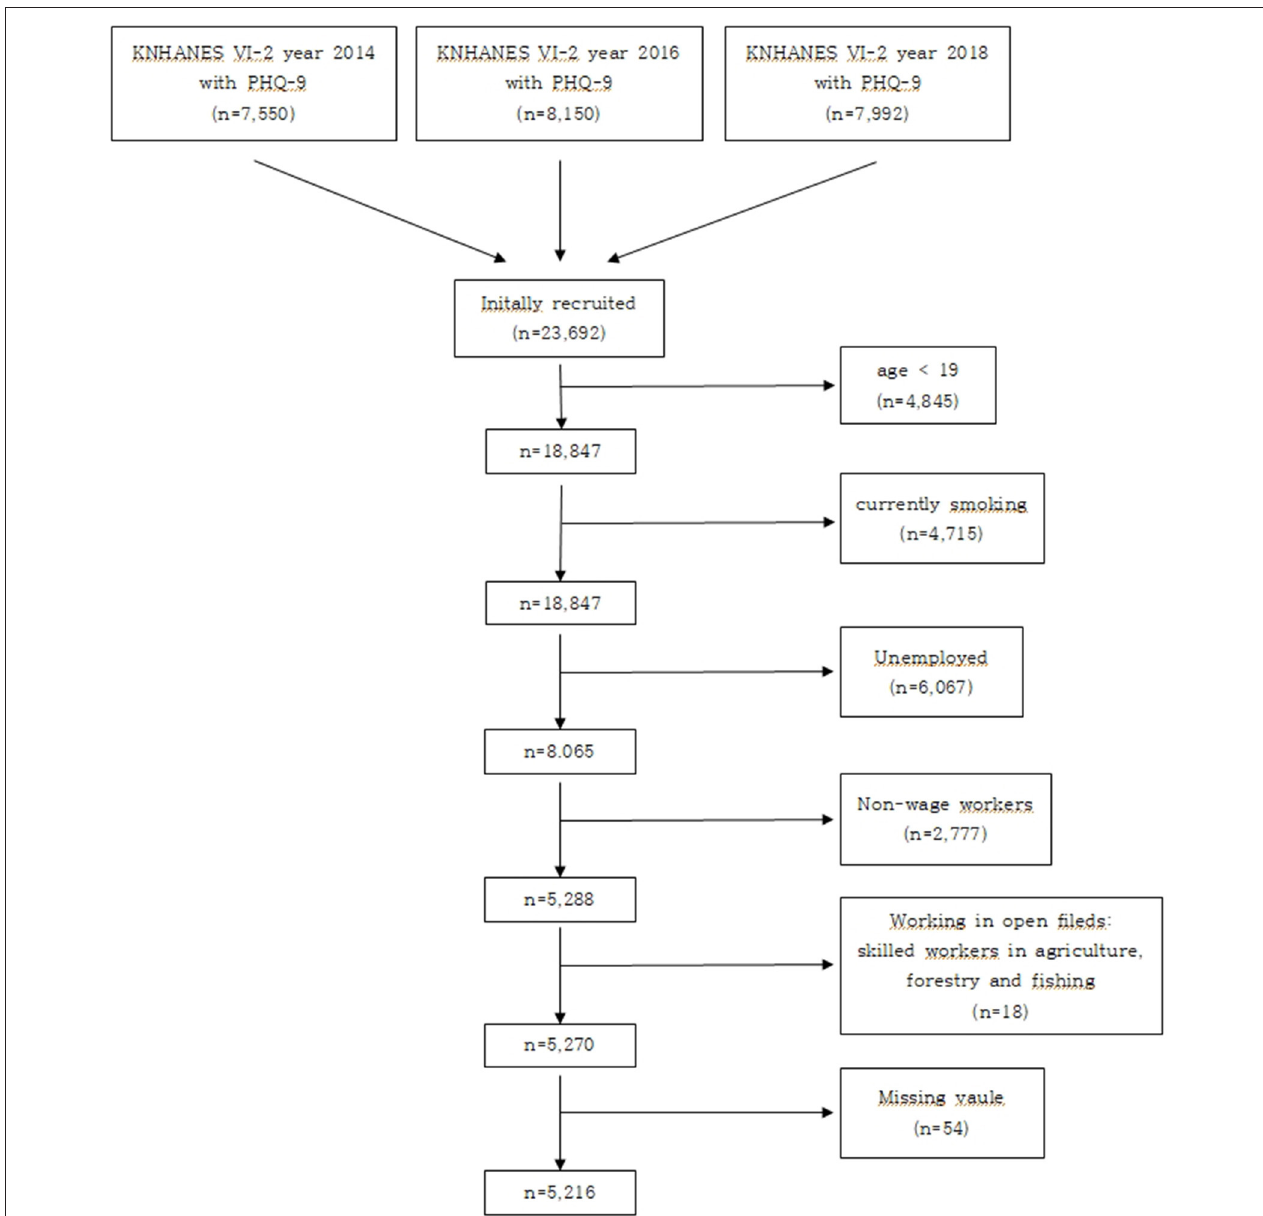
FIGURE 1 | The schematic flow of the inclusion and exclusion criteria of